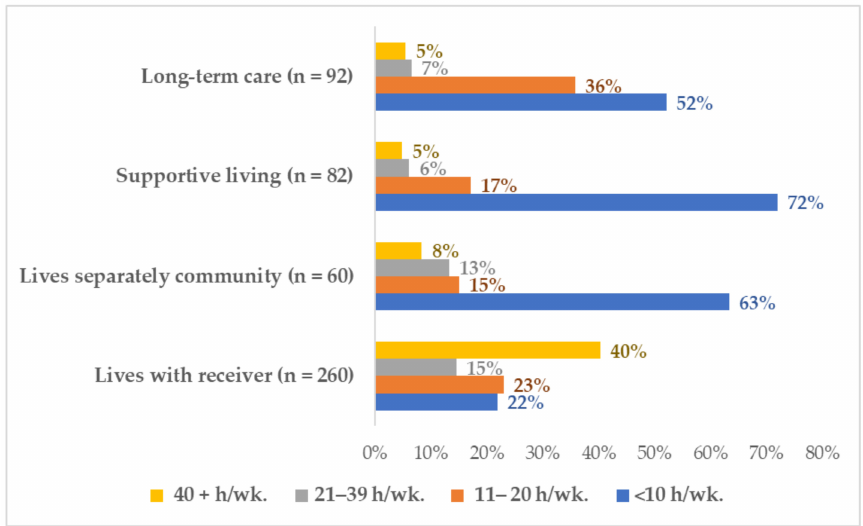
Figure 1. Pre-COVID-19 care work by receiver’s